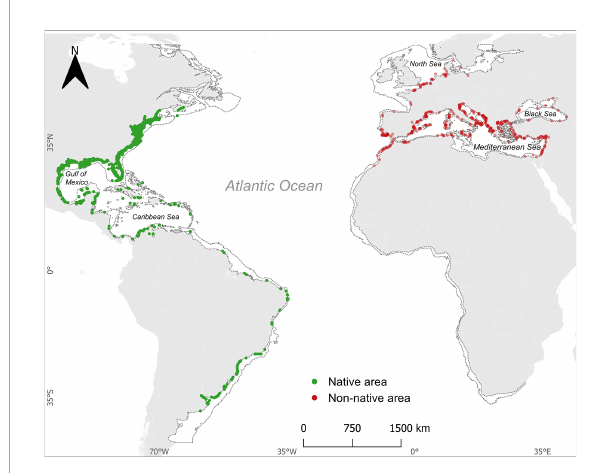
FIGURE 1 Location of the 2130 Atlantic blue crab Callinectes sapidus Rathbun, 1896 presence points used for Bayesian Additive Regression Tree modeling. Dotted lines represent the maximum depth of 200 m. The red dots represent the records collected in the non-native area, while the green dots represent the records collected in native